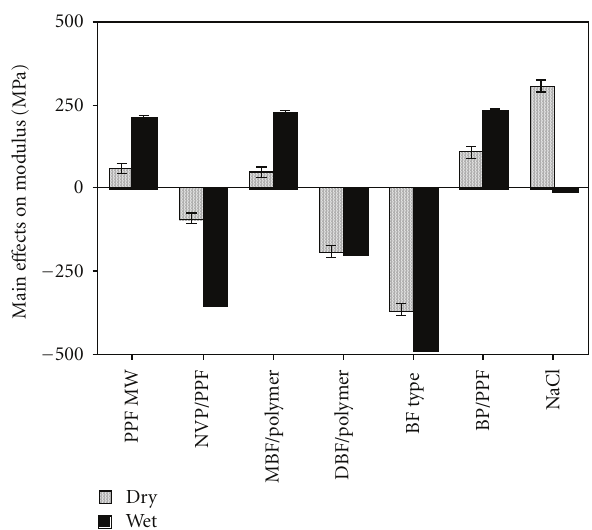
Figure 3: The main e ff ects of the parameters on the compressive modulus of the crosslinked PPF composites. A positive number indicates an increase in the modulus as the parameter was changed from a low ( − ) level to a high (+) level. A negative number indicates a decrease in the modulus as the parameter was changed from a low ( − ) level to a high (+) level. Error bars represent the standard error of the e ff ect (dry ± 16.5 MPa, wet ± 6.2